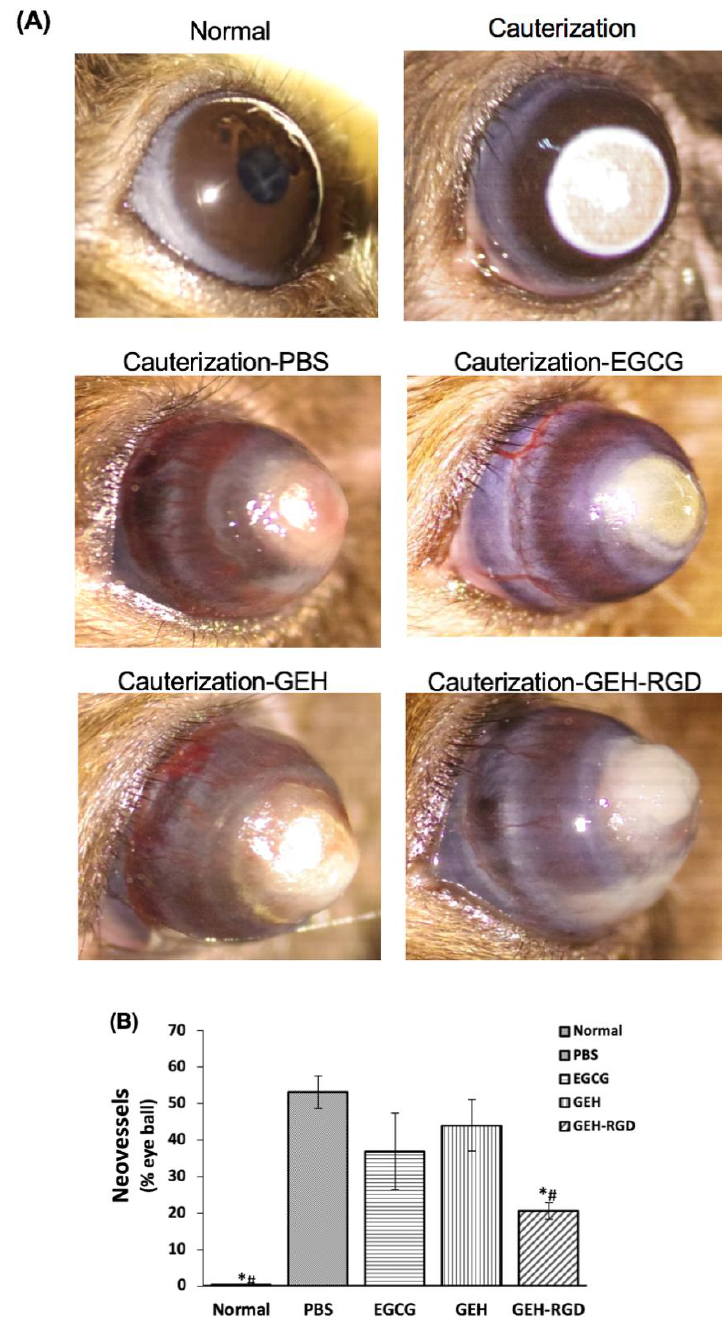
Figure 4. EGCG NPs inhibit neovessels formation in chemical cauterization-induced corneal neovascularization (NV). ( A ) Representative images of normal cornea, cauterized cornea and PBS-, EGCG-, GEH-, or GEH-RGD-treated cornea on day 7 following chemical cauterization. ( B ) The area of blood vessels in the cornea was quantified ( n = 6). * p < 0.05 compared with PBS, # p < 0.05 compared with EGCG and GEH. Abbreviation: PBS: Phosphate buffer saline, EGCG: epigallocatechin-3 gallate, HA: hyaluronic acid, RGD: arginine-glycine-aspartic acid, GE: Gelatin/EGCG self-assembling nanoparticles (NPs), GEH: GE NPs with HA surface coating, GEH-RGD: GE NPs with HA-RGD surface decoration.